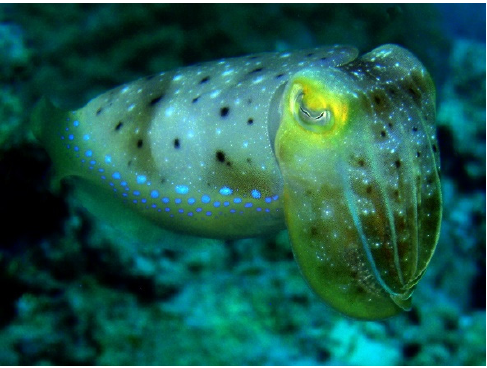
Figure 16. A specimen of Sepia kobiensis . © Maynard Hogg (CC BY-NC-SA 2.0); https://www.flickr.com/.